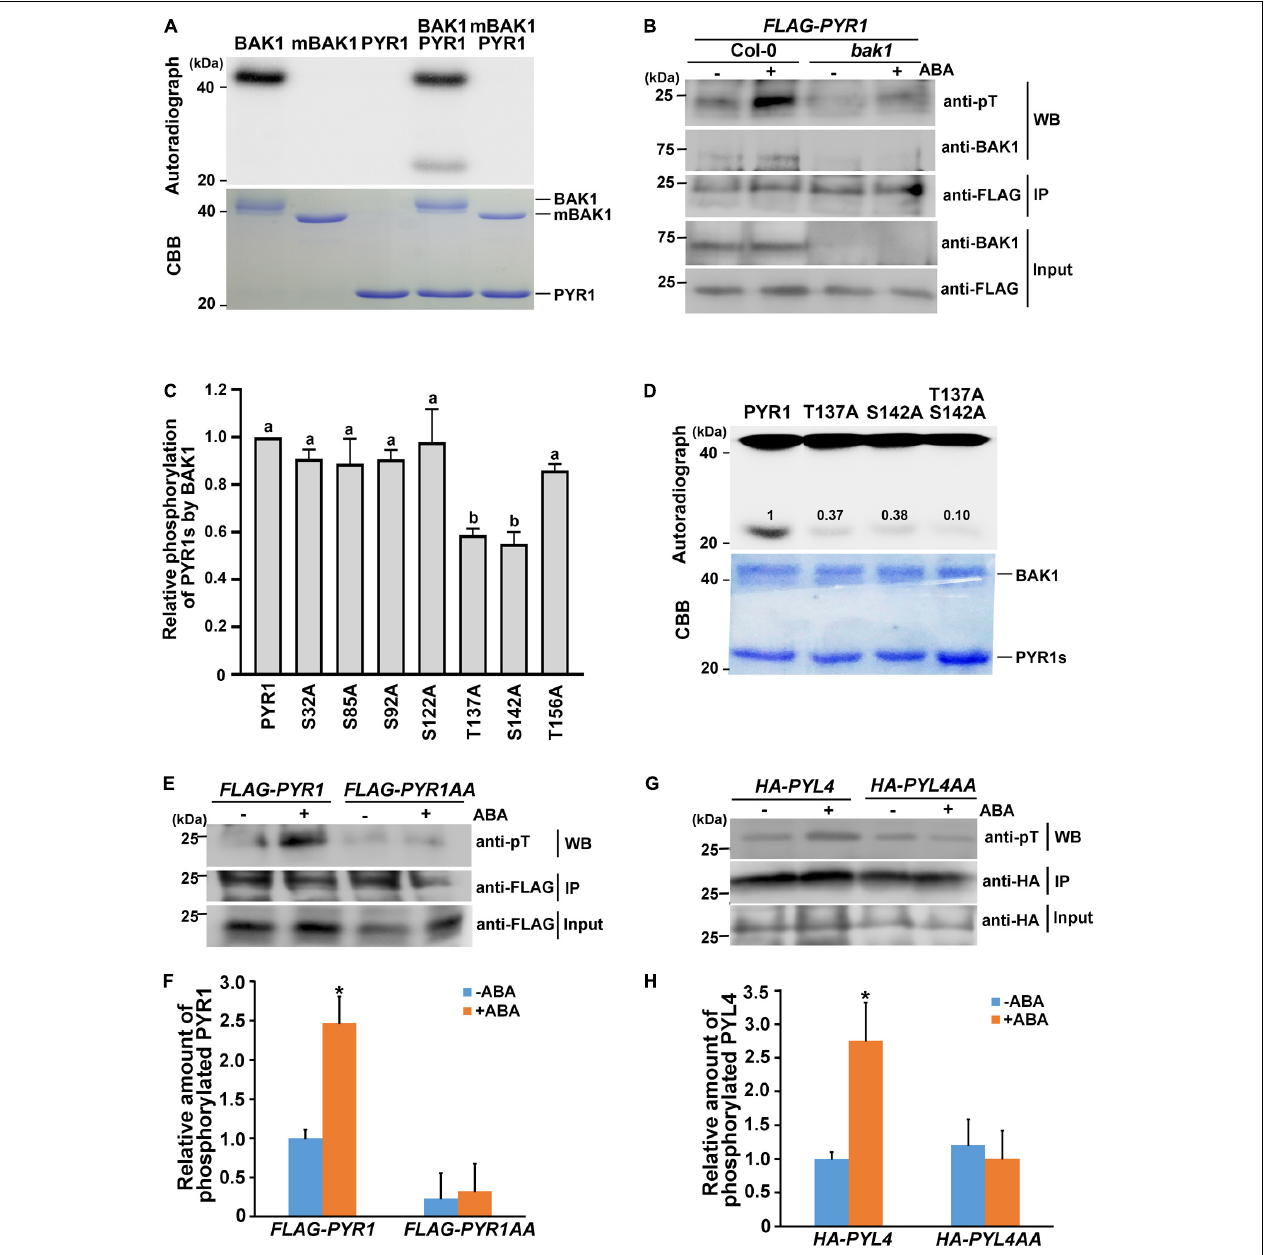
FIGURE 2 | BAK1 phosphorylates PYR1 on T137 and S142 sites. (A) BAK1 phosphorylates PYR1 in vitro . An in vitro kinase assay was performed using either HIS-tagged BAK1 kinase domain (BAK1) or kinase-dead form of BAK1 (mBAK1), and HIS-tagged PYR1 (PYR1). (B) In vivo phosphorylation of PYR1 is reduced in the bak1 mutant. FLAG-PYR1 -transfected protoplasts of Col-0 and bak1 mutant plants were analyzed using western blotting with an anti-phosphothreonine antibody. (C) An in vitro kinase assay was performed to screen for putative phosphorylation sites of PYR1 by BAK1 using mutagenized variants of PYR1. Phosphorylation levels of each PYR1 variant were quantified using Image J software and presented as values relative to the phosphorylation levels of native PYR1 by BAK1 (set as 1). Experiments were repeated thrice. Different letters are statistically different analyzed by one-way ANOVA and Tukey’s multiple comparisons test ( P < 0.05). (D) In vitro kinase assays indicate that BAK1 phosphorylates the T137 and S142 residues of PYR1. Phosphorylation levels of PYR1 variants with single and double alanine substitutions at these sites (T137A, S142A, or T137AS142A) were compared with levels of native PYR1. The values shown indicate the relative amount of phosphorylated PYR1 for each PYR1 variant. (E) ABA-induced PYR1 phosphorylation was suppressed in transgenic plants expressing PYR1AA . (F) Relative amounts of phosphorylated PYR1 or PYR1AA in each transgenic plant in the absence or presence of ABA were quantified using Image J software from the picture in (E) and two independent experiments as shown in Supplementary Figure 7b (* P < 0.05, compared with samples without ABA). (G) ABA-induced PYL4 phosphorylation was suppressed in the protoplast transfected with a mutated HA-PYL4 construct. (H) Relative amounts of phosphorylated PYL4 or PYL4AA in each protoplast in the absence or presence of ABA were quantified using Image J from the picture in (G) and two independent experiments as shown in Supplementary Figure 7c (* P < 0.05, compared with samples without ABA).